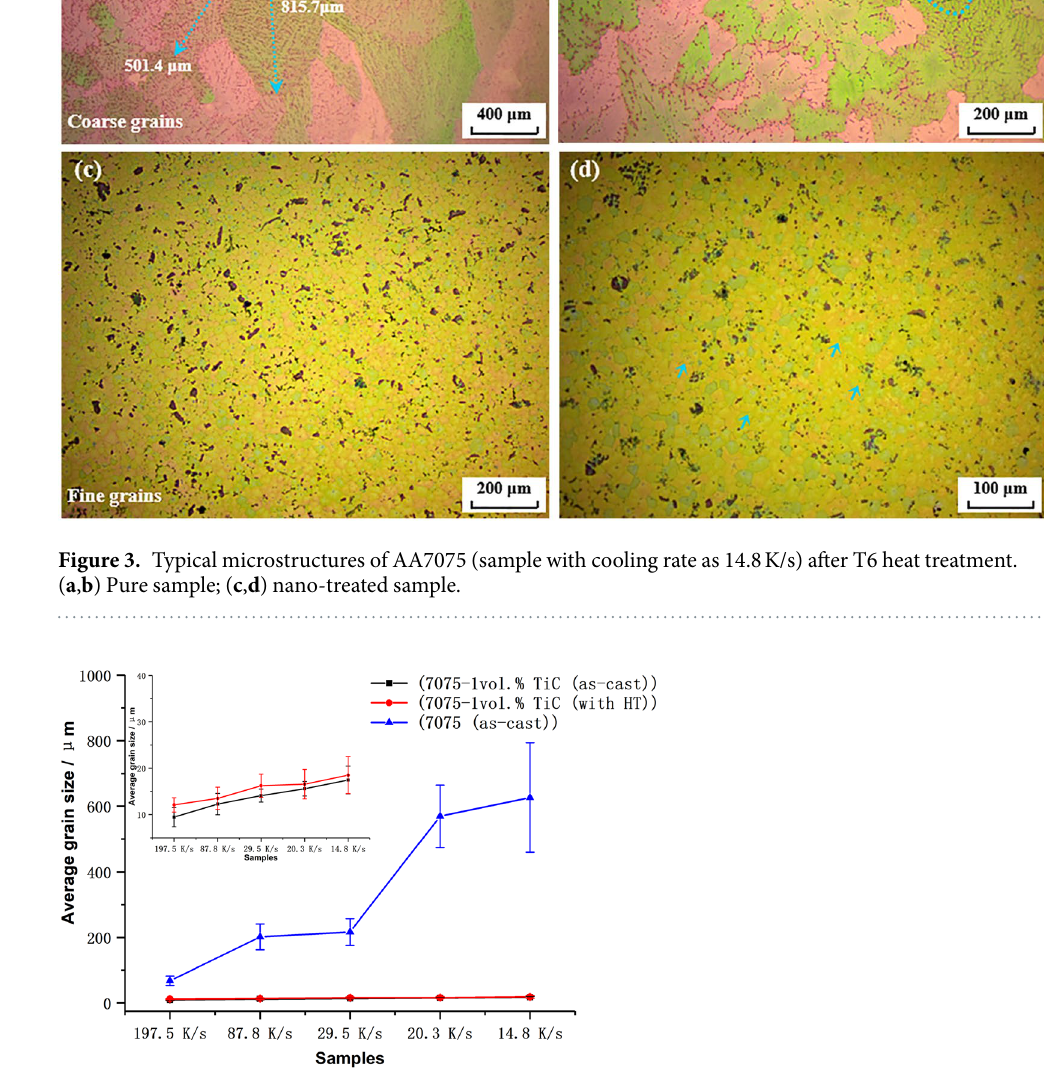
Figure 4. The variation in average grain sizes of AA7075 alloys before and after nano-treating. The embedded image is the partial enlargement of mean grain sizes of nano-treated AA7075, indicating a superior thermal stability of grain size before and after heat treatment. However, the grains in basic AA7075 alloys grow even coarser after heat treatment as clearly illustrated in Fig.